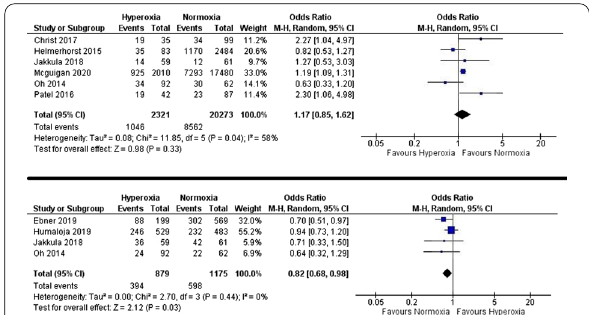
Fig. 1. Forest plot analysis on mortality and neurological out- come in hyperoxic patients who survived after CA compared to normoxic ones. Analysis performed with random effect model and Mantel–Haenszel (M-H) Conclusion. In adult survivors after cardiac arrest, hyperoxia is asso- ciated with a worse neurological outcome. However, more studies are needed to evaluate the effect of hyperoxia on mortality in this patient